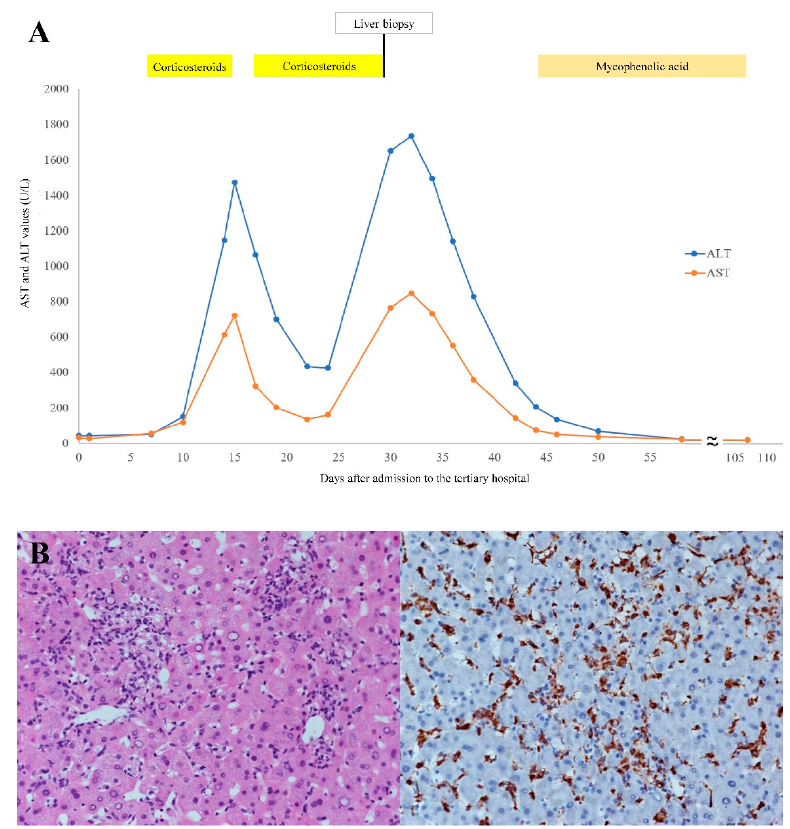
Figure 1. ( A ) Trend of liver enzymes since admission to the tertiary hospital; AST: aspartate aminotransferase; ALT: alanine aminotransferase. ( B ) Histopathology of the liver reveals ( left ) acute hepatitis with neutrophils and lymphocytes infiltration in H&E stain and ( right ) Kupffer cell proliferation highlighted by CD68 immunohistochemical stain (both 200X). H&E: hematoxylin and